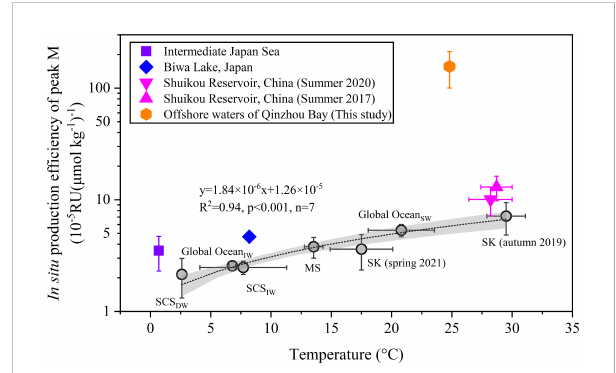
FIGURE 9 Assessing the relationship between the in situ production ef fi ciency of peak M (i.e., the slope of linear regressions between peak M and AOU) and temperature across inland and marine systems. Gray circles indicate the data used for the linear regression and labeled accordingly. Gray shading shows the 95% con fi dence bands. SCS IW , intermediate water of the South China Sea (200 – 1000 m); SCS DW , deep water of the South China Sea (> 1000 m); Global Ocean SW , surface water of the global ocean (0 – 200 m); Global Ocean IW , intermediate water of the global ocean (200 – 1000 m); MS, dark Mediterranean Sea (> 200 m); SK, Shuikou Reservoir. Data on SCS, MS, Japan Sea, and Global Ocean IW came from Wang R. et al. (2021). Data on the Shuikou Reservoir came from Qu et al. (2022). Data from Lake Biwa and Global Ocean SW were recalculated from the results reported by Thottathil et al. (2013) and Catala ́ et al. (2016),